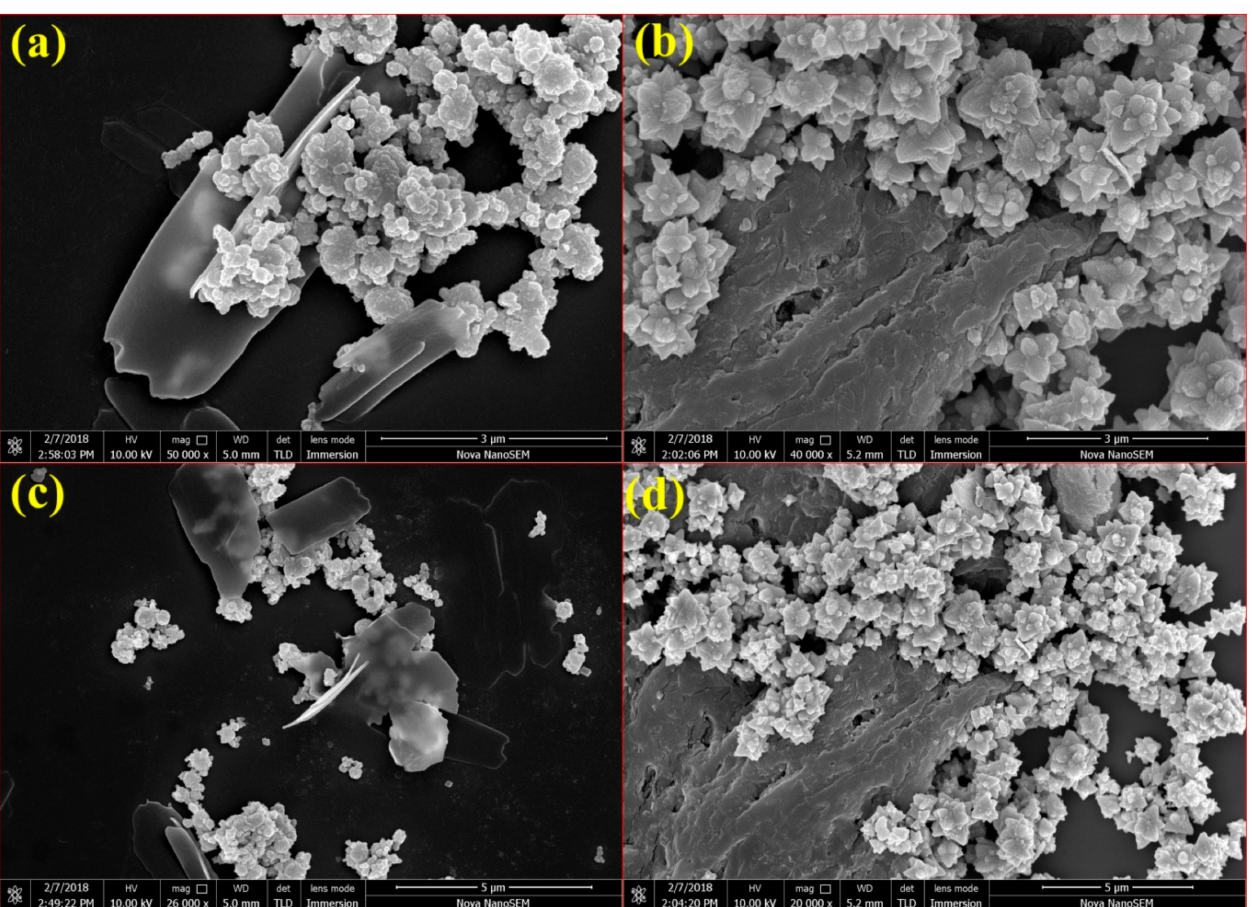
Figure 3. SEM micrograph of ZnO/graphene nanocomposites( a , b ) S1, and ( c , d ) S2. The elemental compositions of the samples and functional groups/elements